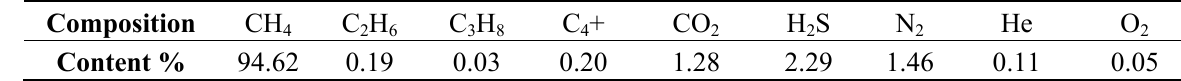
Table 13. The composition of the validation pipeline.